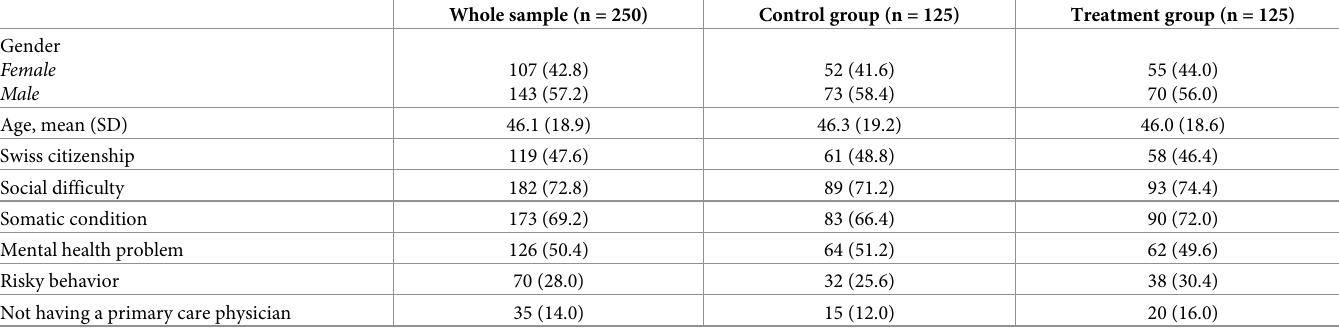
Table 1. Demographic characteristics and determinants of health in the sample